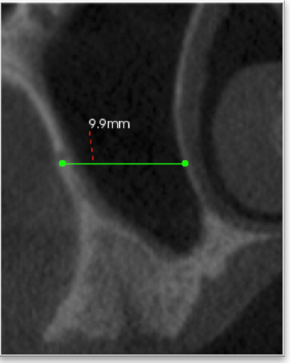
Fig. 6. Distance from the artery to the medial sinus